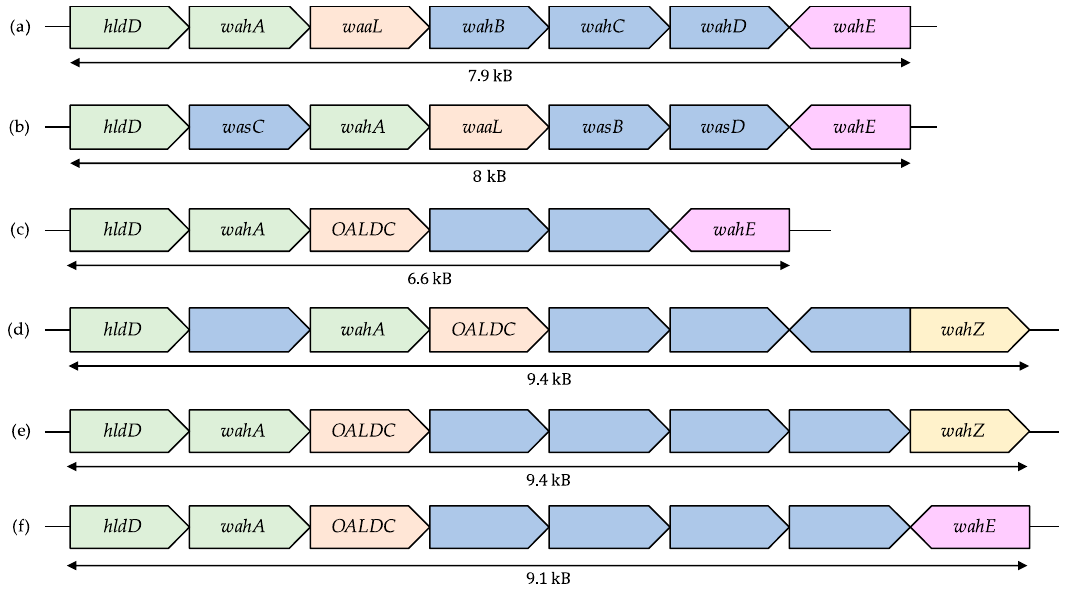
Figure 4. Comparison of the six most common wa Region 1 genomic organization in Aeromonas . Common genes ( hldD and wahA ) in these genomic organizations are shown in green, O-antigen ligase domain containing proteins in orange, wahE in purple, wahZ in yellow, and both characterized and uncharacterized glycosyltransferases are shown in blue. ( a ) Type 1 wa Region 1, found in A . bestiarum , A . dhakensis , A . hydrophila , A . piscicola , and A . schubertii ; ( b ) Type 2 wa Region 1, found in A . salmonicida species; ( c ) Type 3 wa Region 1, as in A . aquatica , A. caviae , A . media and A . sanarelli ; ( d ) Type 4 wa Region 1, found in A . australiensis , A . jandaei , and A . veronii ; ( e ) Type 5 wa Region 1, in A . enteropelogenes and A . finlandensis ; and ( f ) Type 6 wa Region 1, as found in A . popoffi .